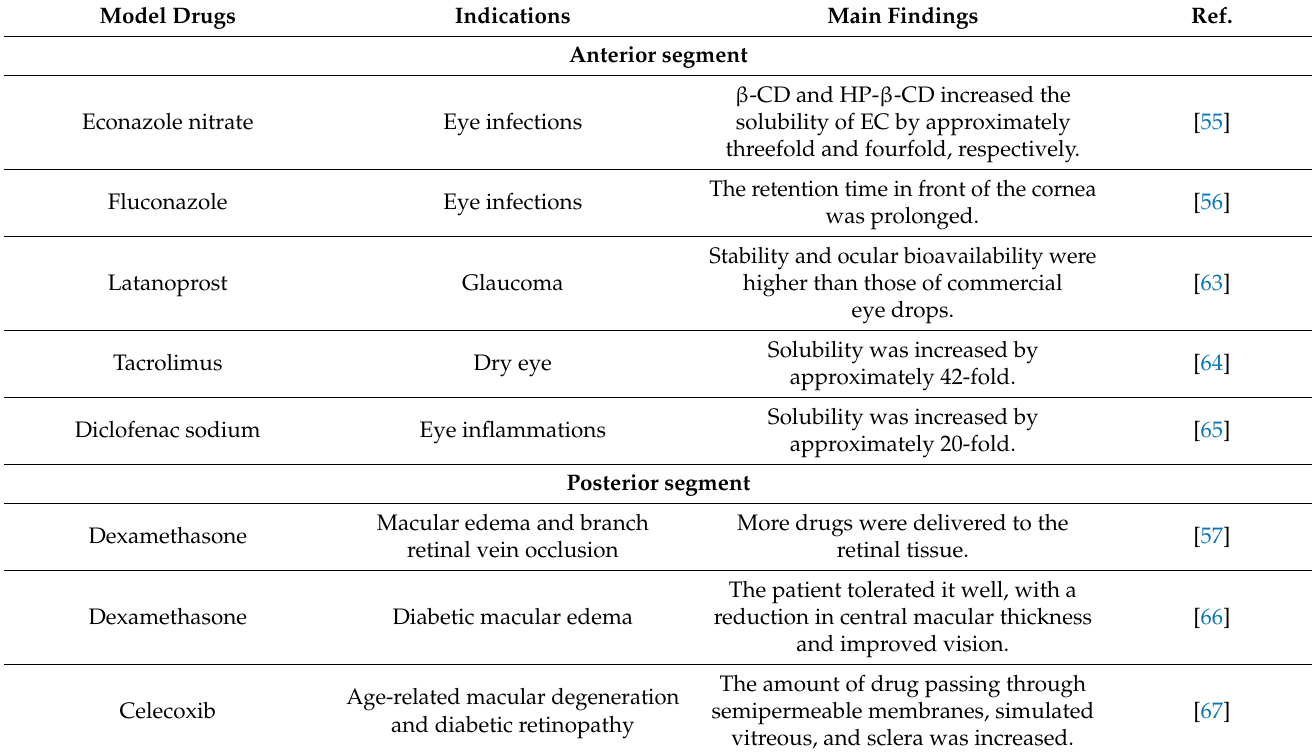
Table 2. Cyclodextrin eye drop delivery systems in the application of the anterior and posterior segments of the